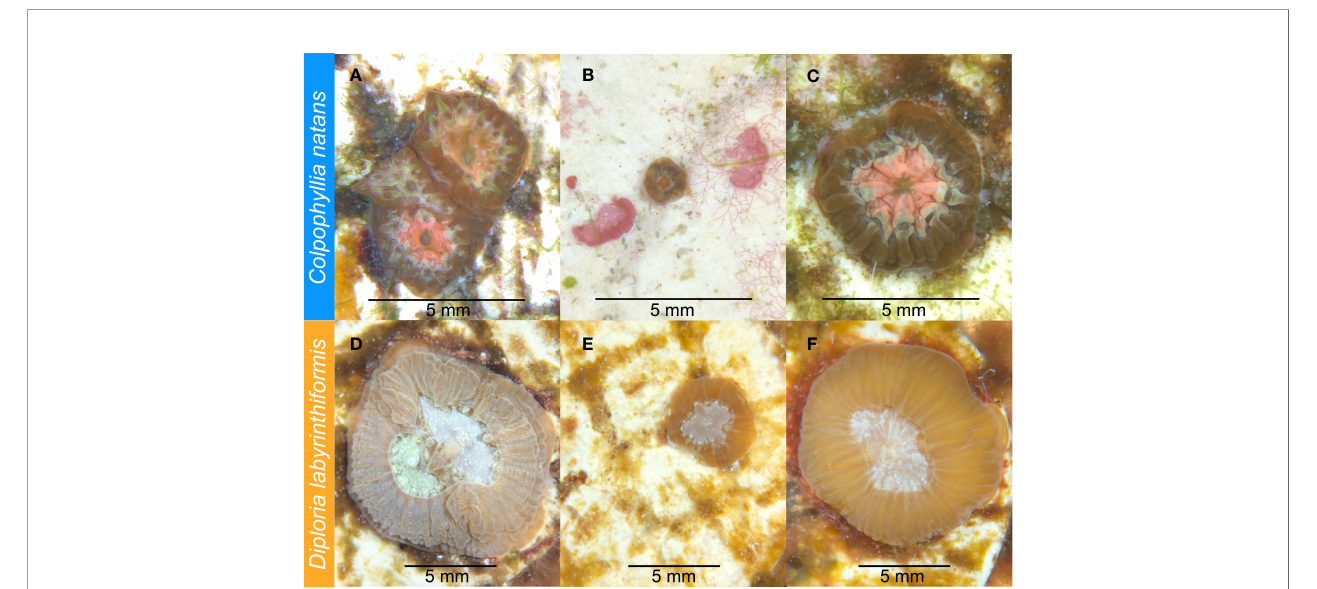
FIGURE 2 | Four-month-old Colpophyllia natans (A-C) and eight-month-old Diploria labyrinthiformis (D-F) recruits prior to SCTLD exposure. (A) C. natans “ chimera ” (multi-genotype entity), made up of individual recruits ranked as “ medium ” in size. (B) C. natans “ solitary ” recruit (single-genotype entity), ranked as “ small ” in size. (C) C. natans solitary recruit, ranked as “ large ” in size. (D) D. labyrinthiformis chimera, made up of two individual recruits ranked as “ medium ” and “ large ” in size. (E) Small, solitary D. labyrinthiformis solitary recruit. (F) Large, solitary D. labyrinthiformis